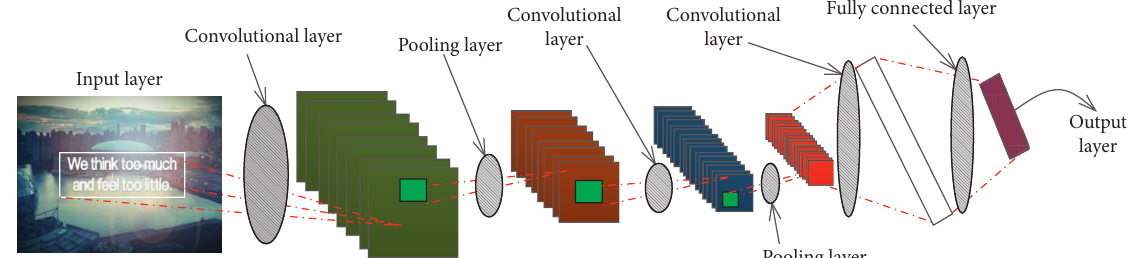
Figure 2: Working principle of convolutional neural